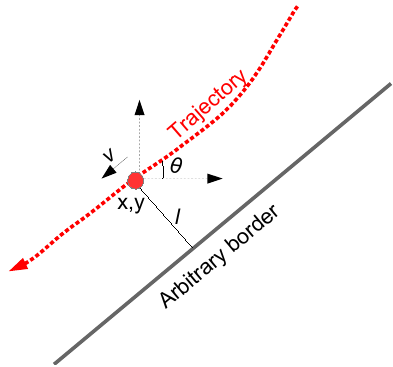
Figure 2. Feature attributes— θ , l , and x, y —used in the current study. The attribute v , which was